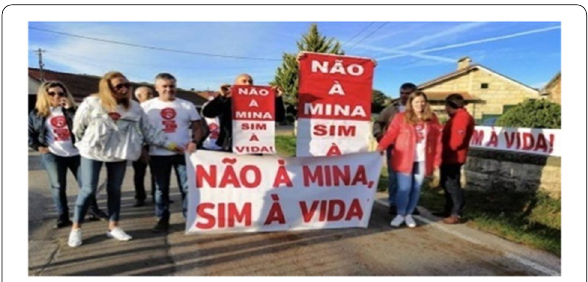
Fig. 2 Demonstration against lithium exploration (“No to the mine/ Yes to life”). Source: